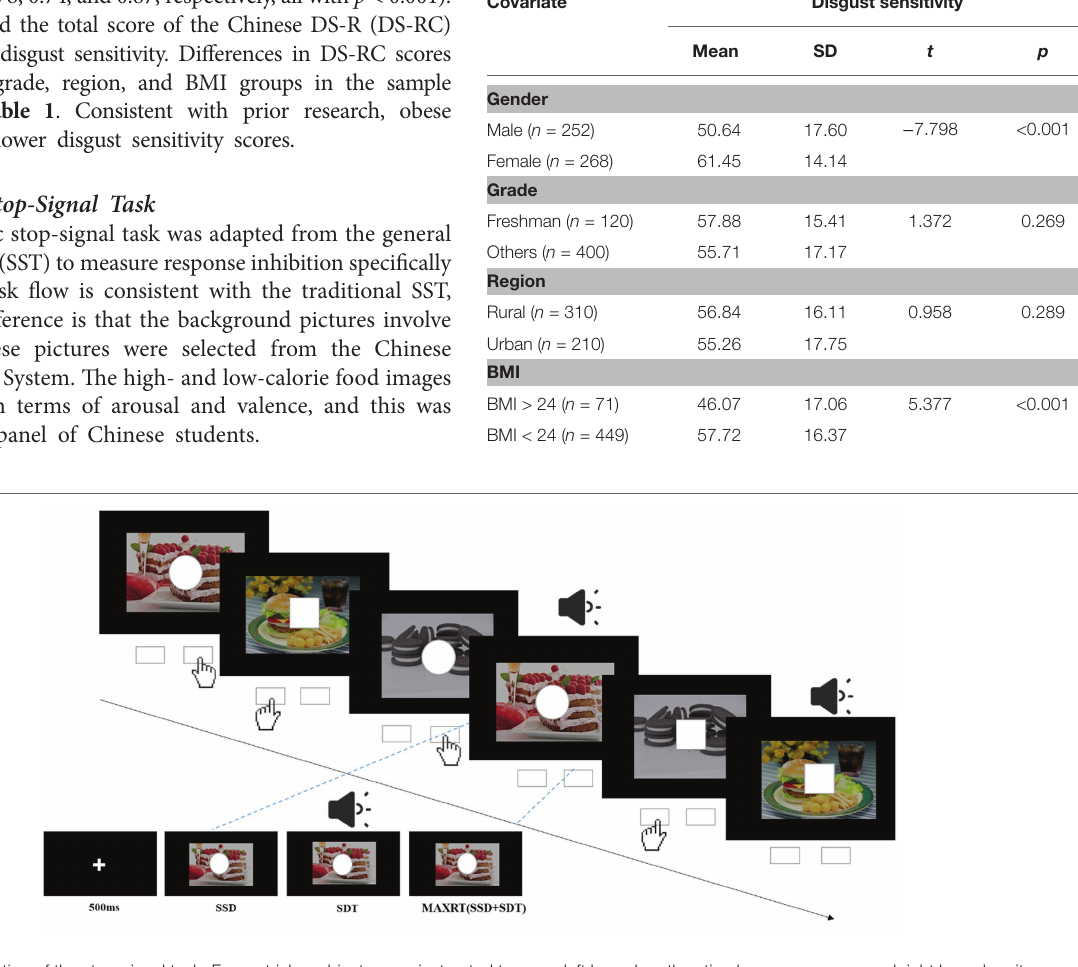
FIGURE 1 | Illustration of the stop-signal task. For go trials, subjects were instructed to press left key when the stimulus was a square and right key when it was a circle. For a quarter of all trials, the go stimulus was followed by an auditory stop signal (pure tone) after a variable stop-signal delay (SSD). SDT, duration of the stop signal; MAXRT, maximum reaction time.